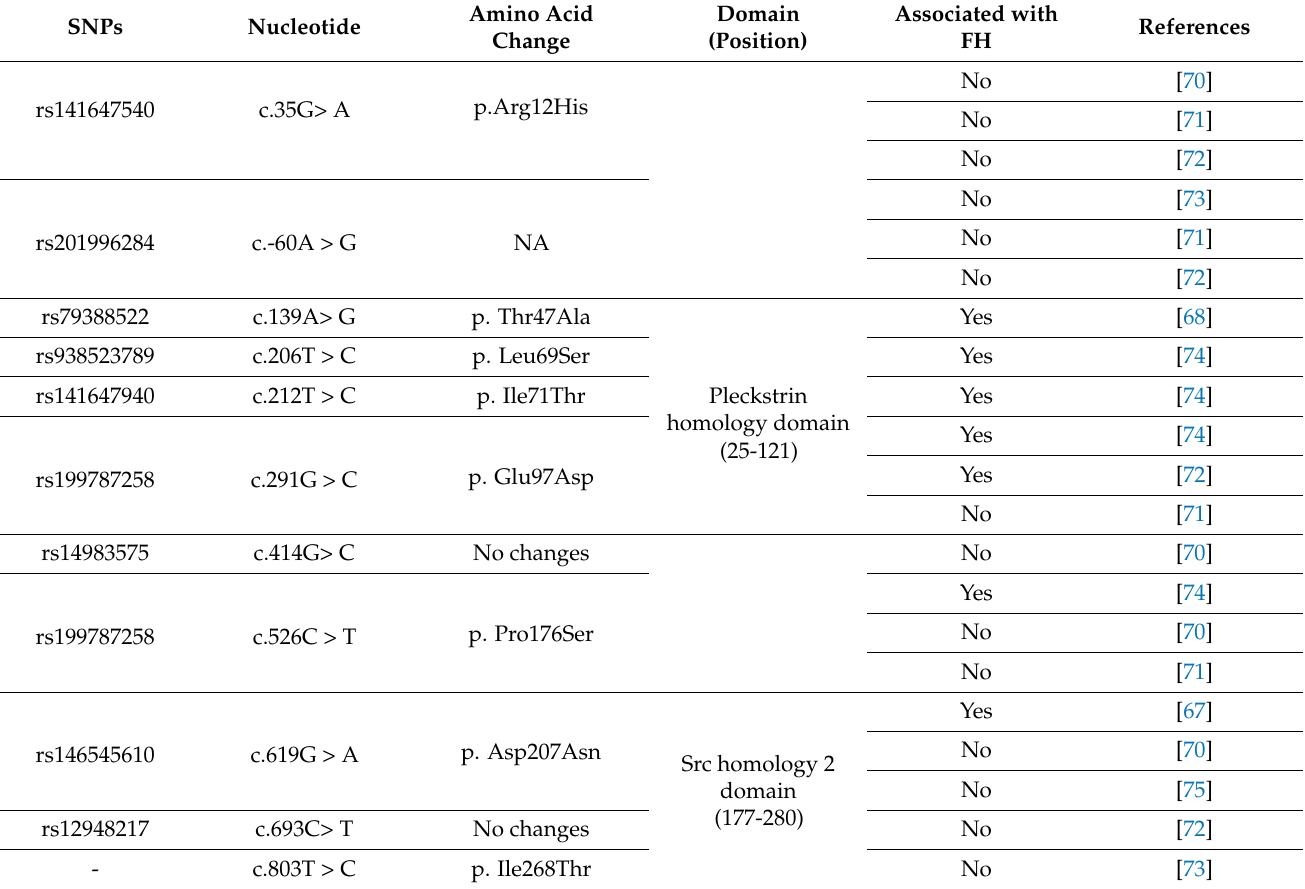
Table 1. List of STAP1 mutations and familial hypercholesterolemia reported